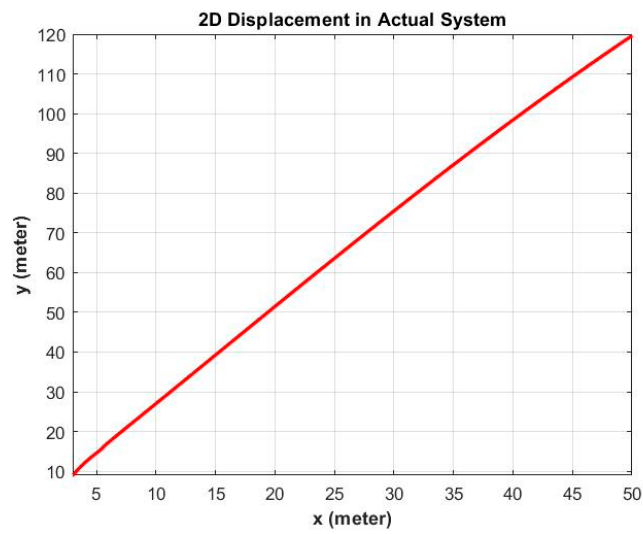
( ) (cid:0) (cid:1) φ 2 s = x 2 − y = 0 in the actual system 2 0 x y φ = − = in the actual system 2s